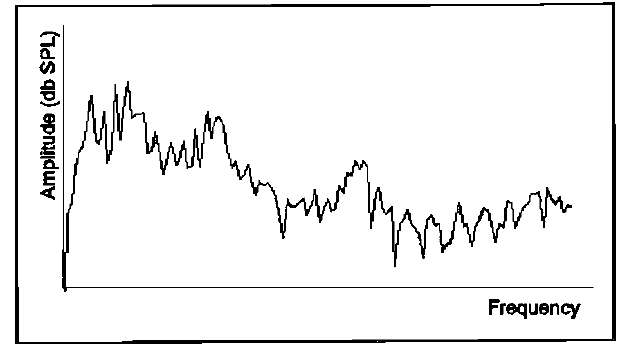
Figure 3. The original spectrum before thresholding, plotted from 0 Hz to 4000 Hz (x-axis). The y-axis gives the spectral amplitude in dB SPL. The scaling is not shown and is not important.